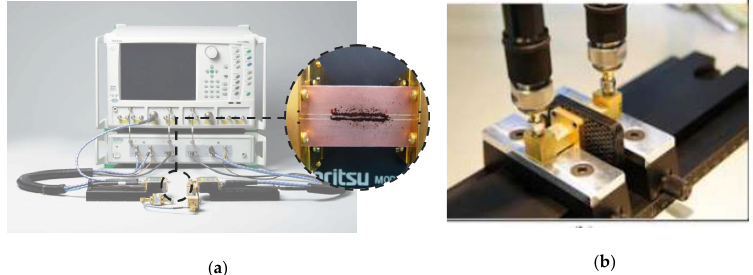
Figure 3. ( a ) Measurement configuration for nanoinclusions powders ( b ) measurement configuration for absorber thin plates, adapted from [23].